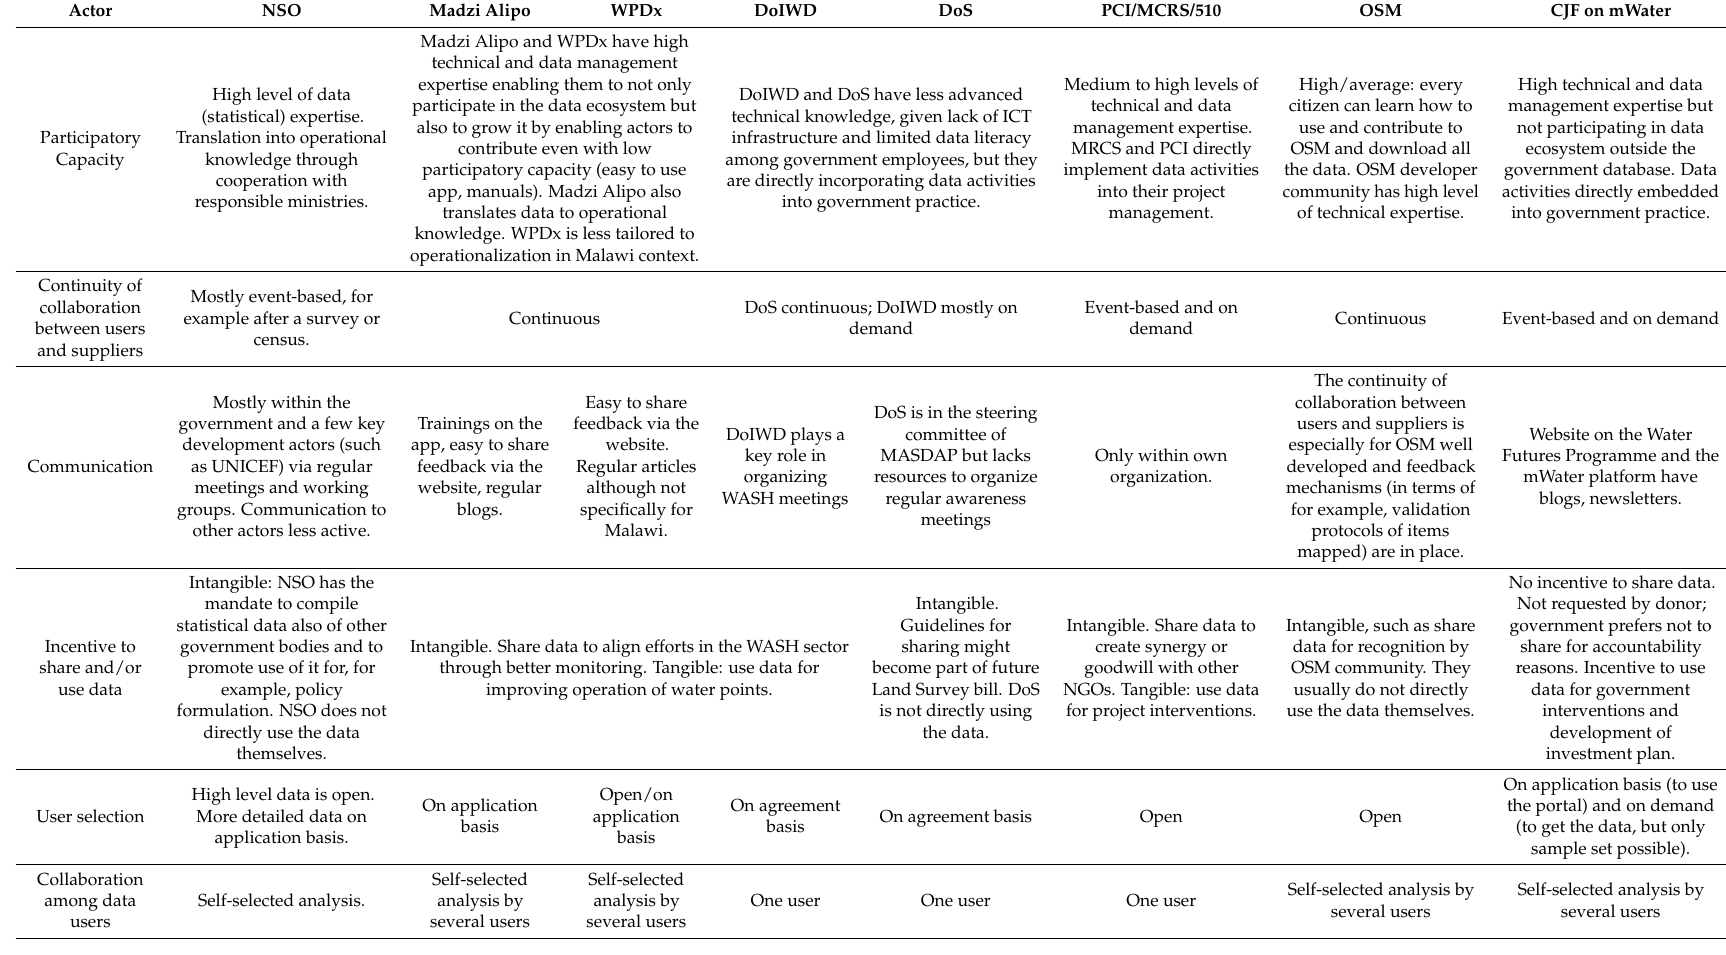
Table 7. Data ecosystem governance dimension of the data sets of the main actors in the WASH data ecosystem. PCI, MCRS and 510 are put into one column given similarities on the